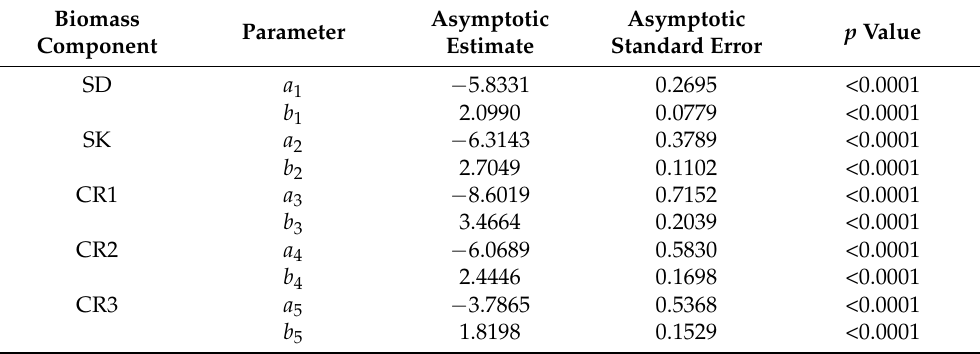
Table 3. Parameter estimates and their asymptotic standard error and p values for the Agg-ML biomass equation